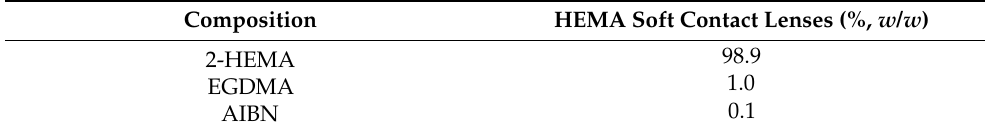
Table 1. Composition and content of soft contact lenses.